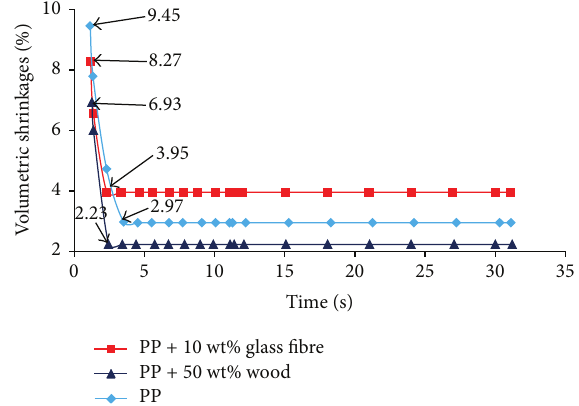
Figure 6: The residual volumetric shrinkages distribution occurs at the centre of the surface of the thin-walled parts for PP, PP + 10 wt% glass fibre, and PP + 50 wt%